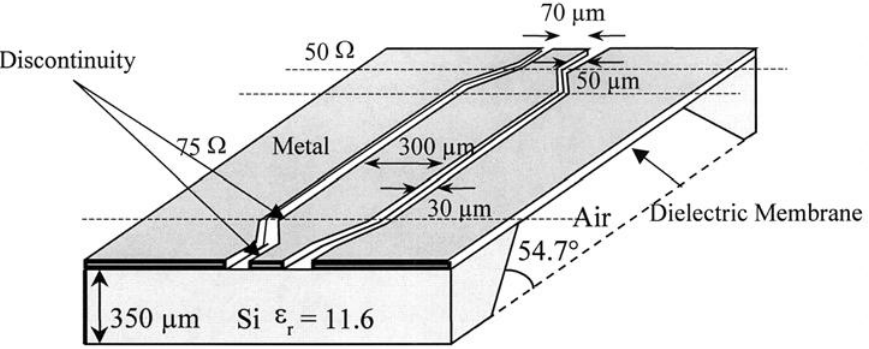
FIGURE 3 Schema of the MCPW transmission